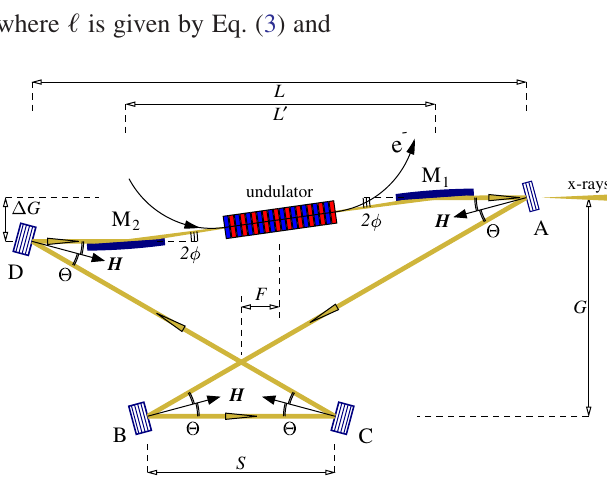
FIG. 4. (Color) Same as Fig. 3, with the ellipsoidal mirrors M 1 and M 2 used as collimating and focusing elements.